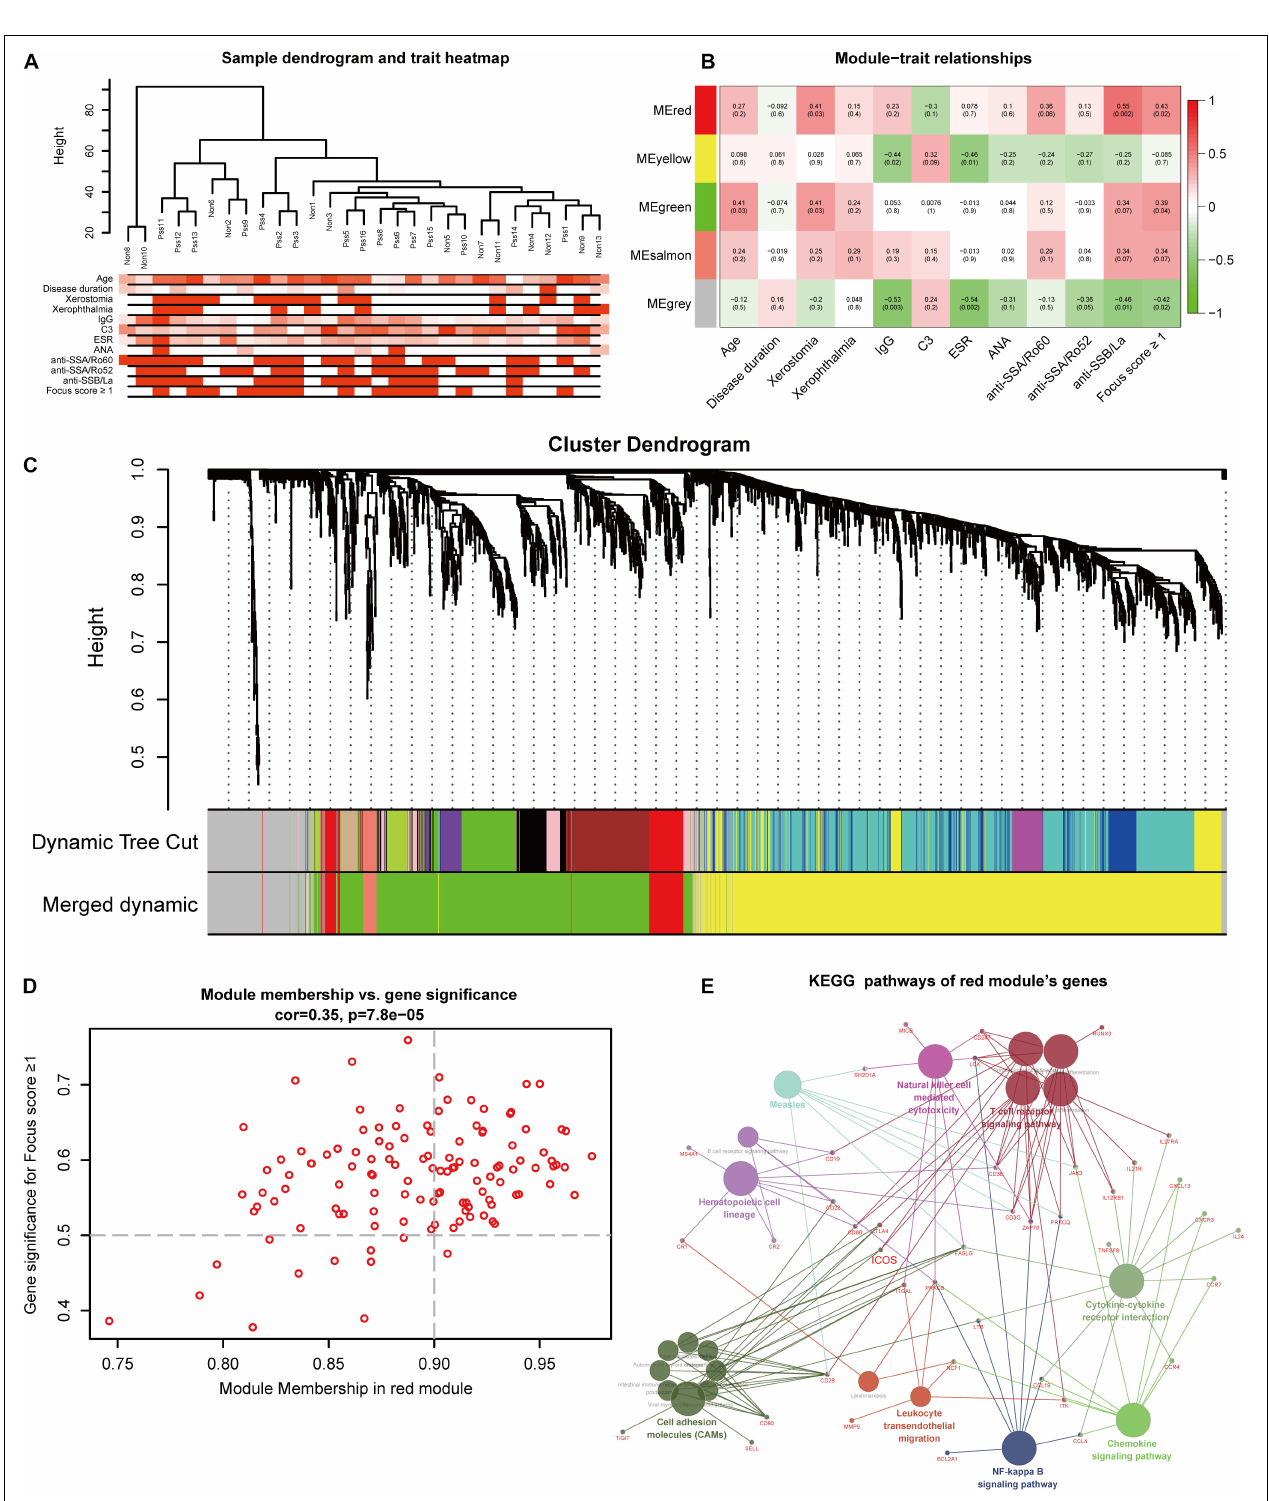
FIGURE 3 | Identification of modules and hub genes closely associated with clinical traits of primary Sjögren’s syndrome (pSS) in RNA-seq data through weighted gene co-expression network analysis. (A) Hierarchical clustering dendrograms of genes with clinical traits, (B) heat map of the correlation between module eigenvalues and clinical traits of pSS containing the correlation coefficient and p- value, and (C) dendrogram of all genes showing the change of modules before and after merging. (D) Scatter plot of modular genes in the red module. (E) The network of Kyoto Encyclopedia of Genes and Genomes pathway in the red module.